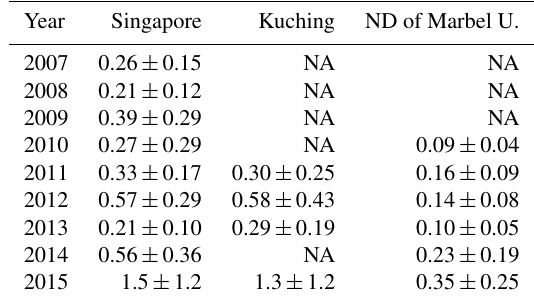
Table 3. August through October means and standard deviations of AERONET 500nm fine-mode AOT for three sites with the longest data record in the Maritime